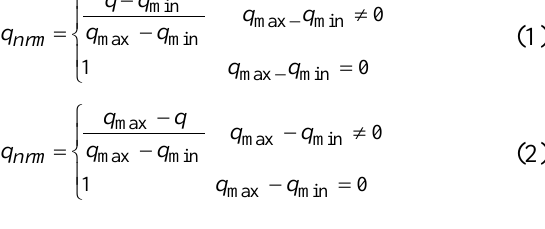
Table 2. Aggregative QoS value for serial pattern